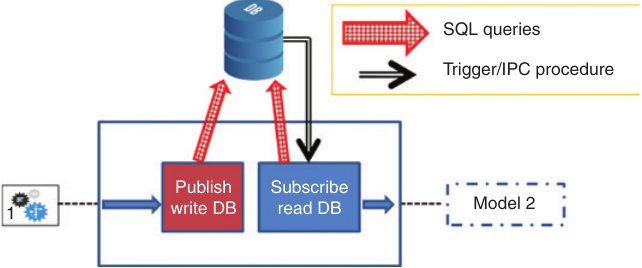
Figure 4: Expected Functionality of the New Simulink Signal/Bus Element (Central